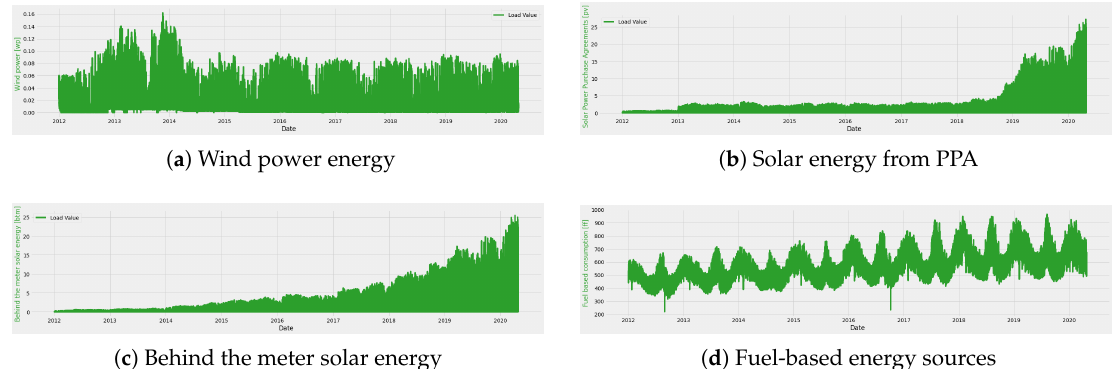
Figure 4. Load values from different energy